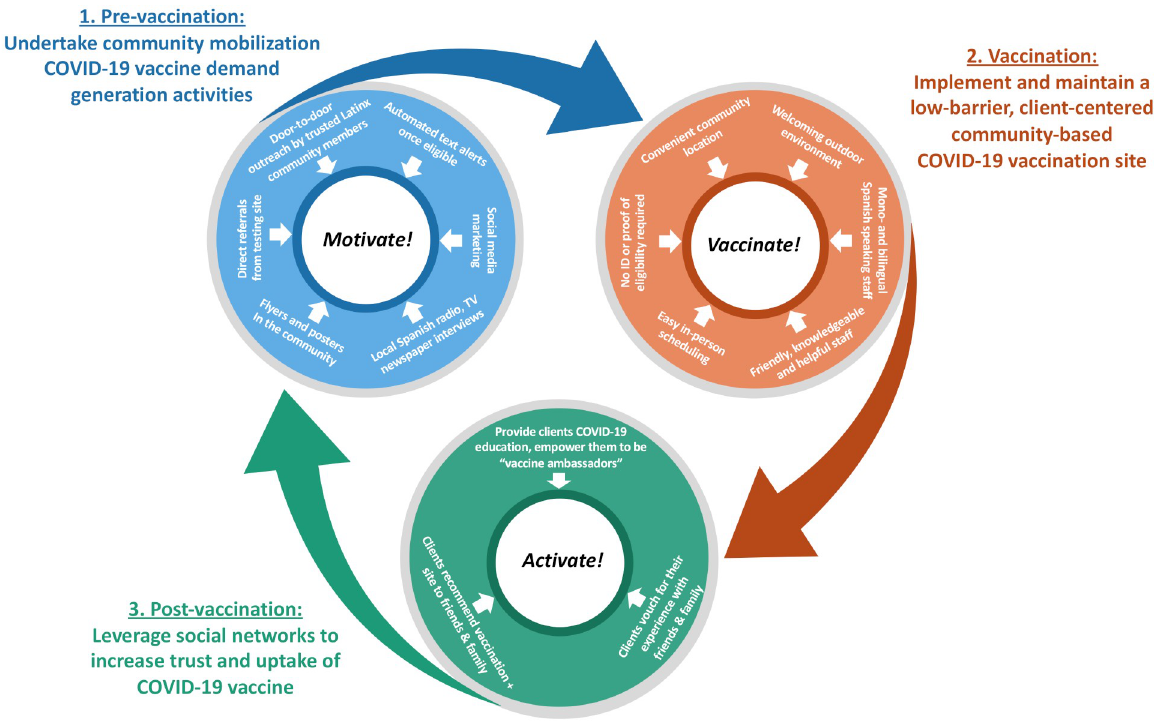
Fig 1. Overview of the “Motivate, Vaccinate and Activate” strategy to increase vaccine uptake among Latinx community members living in San Francisco.